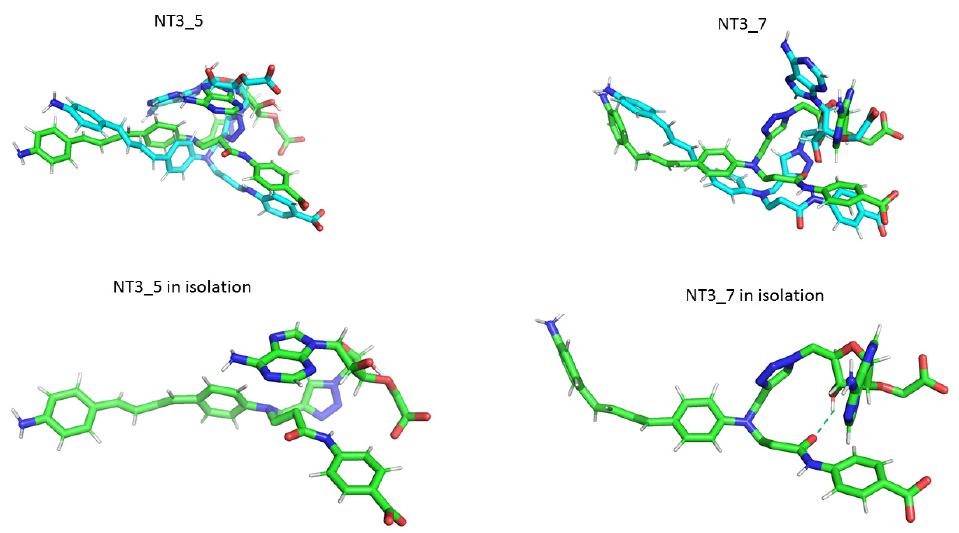
Figure A4. Comparison of NT3_5 and NT3_7 in isolation (green) and bound to eNOS (cyan). The conformation of NT3_5 di ff ered from that of NT3_7 by the relative planarity of its chromophore in the former compared to a largely non-planar chromophore of NT3_7. They di ff ered also by the hydrophobic interactions between the triazole, the adenine, and the first phenyl ring of the chromophore of NT3_5, while stacking of the triazole with the adenine in NT3_7 was stabilized by an intramolecular H-bond between the amide of the hook and the OH of the ribose; the adenine helped to separate the charges of the hook and the nucleotide. Note the similarity between isolated and bound NT3_5 but the quite di ff erent conformations of NT3_7 when isolated and eNOS-bound, the protein limiting the bending of the chromophore with a significant modification of the